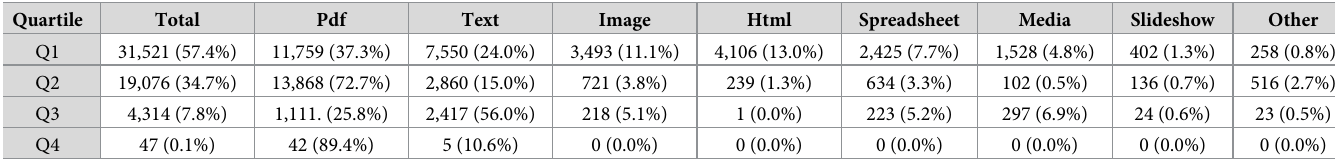
Table 3. Quartile distribution of file formats of the supplementary material.